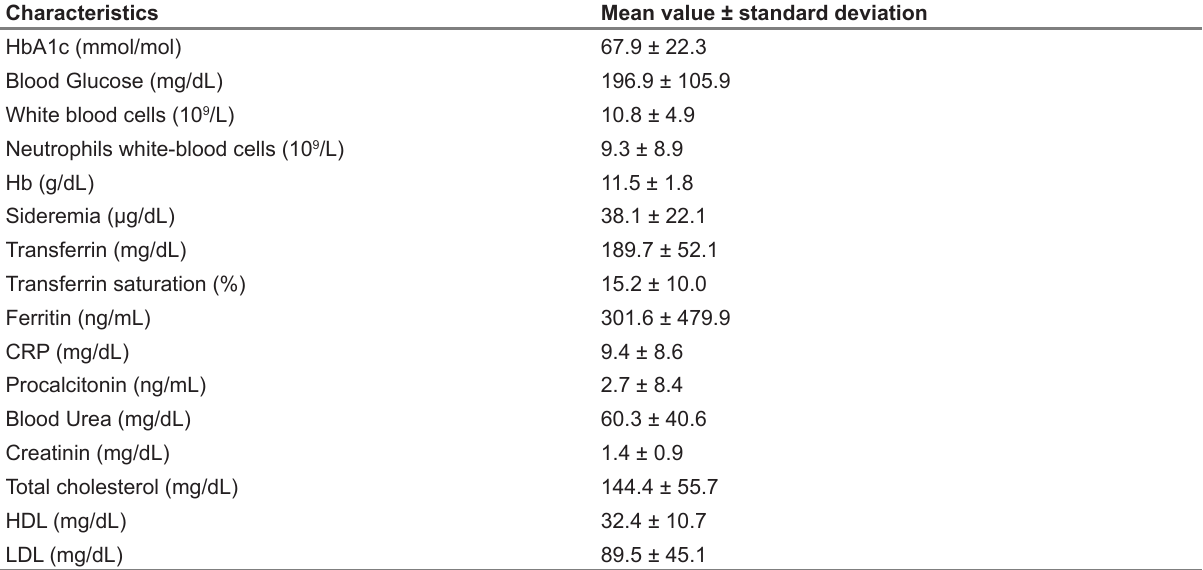
Table 2. Biochemical assays of the 75 patients admitted in the Diabetic Foot Unit